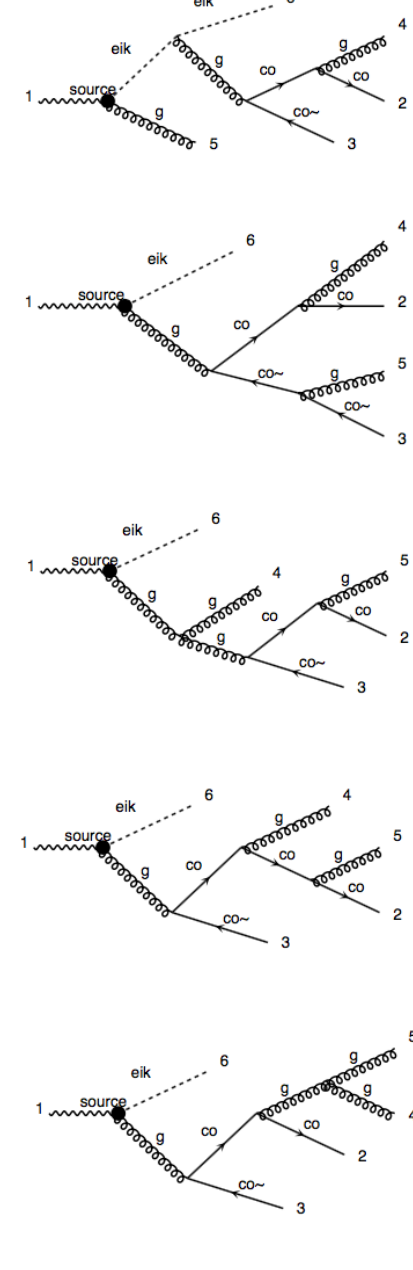
Figure 6 . Diagrams generated by MadGraph5 for the process g ! Q (cid:22) Q 8 ( 1 S 0 ) + g + g . Only half the Feynman diagrams are shown. The other half are obtained by reversing the directions of the arrows on the quark lines. There are no diagrams with ghosts in the (cid:12)nal state since the amplitudes are calculated with physical helicity states.